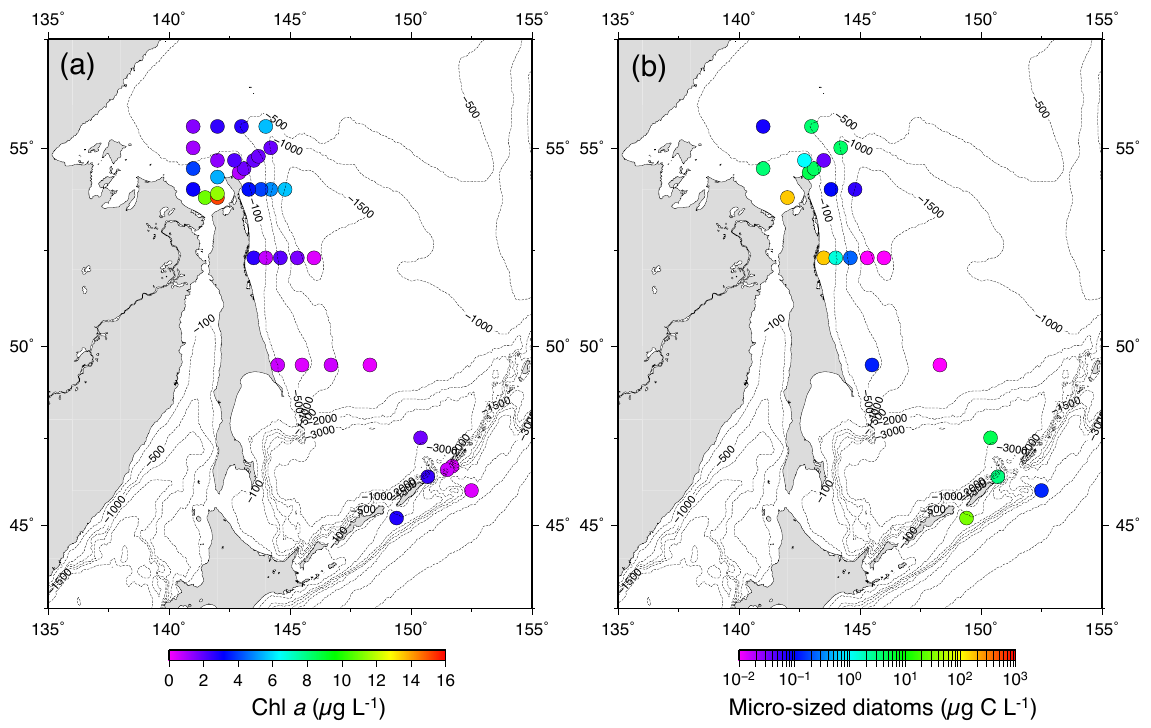
− 1 ) concentration and (b) micro-sized diatoms’ carbon biomass (µgCL − 1 ) in surface waters at